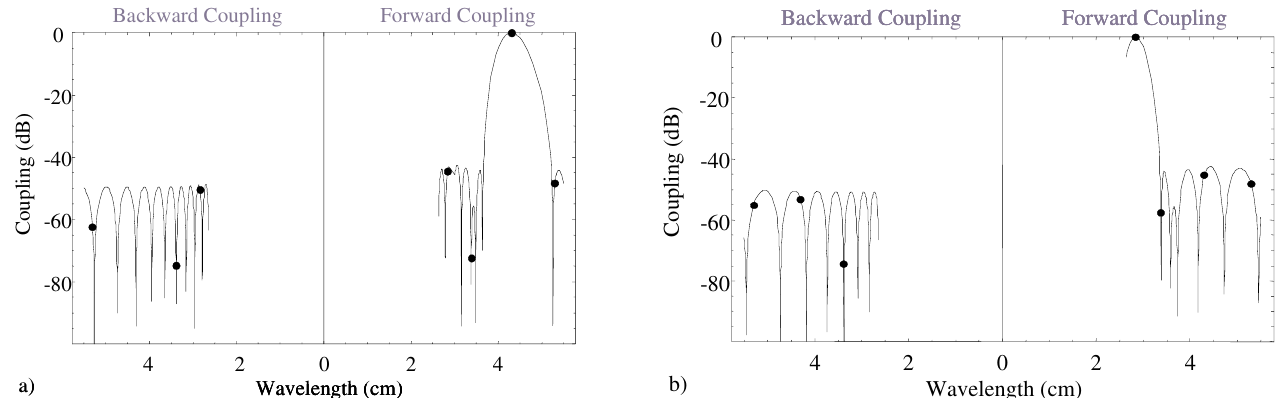
FIG. 6. (Color) Coupling versus guided wavelength. (a) TE normalized to forward coupling of the TE coupler length is 38.3 cm. Number of coupling holes is 51. Points represent TE holes is 44. TE 11 mode are not shown in the backward coupling because they are theoretically zero because of the choice of coupling holes and the TE 11 spacing.